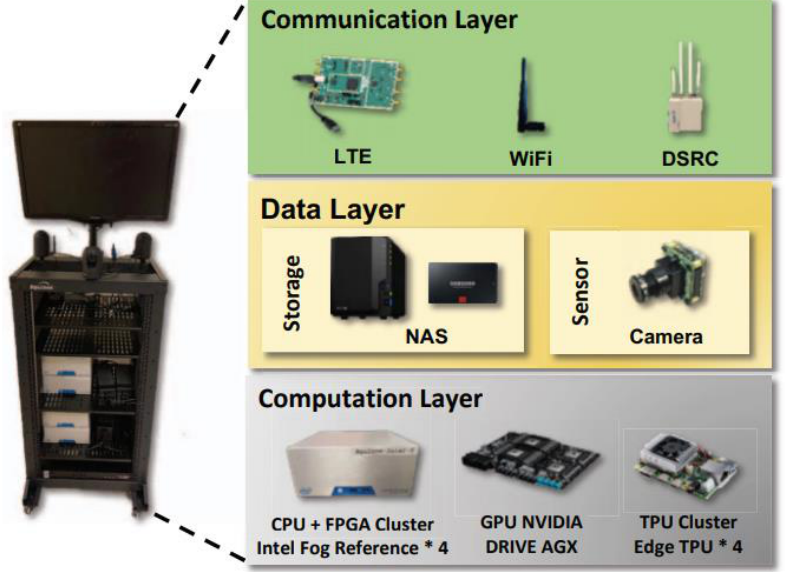
Figure 7. EQUINOX system [20].